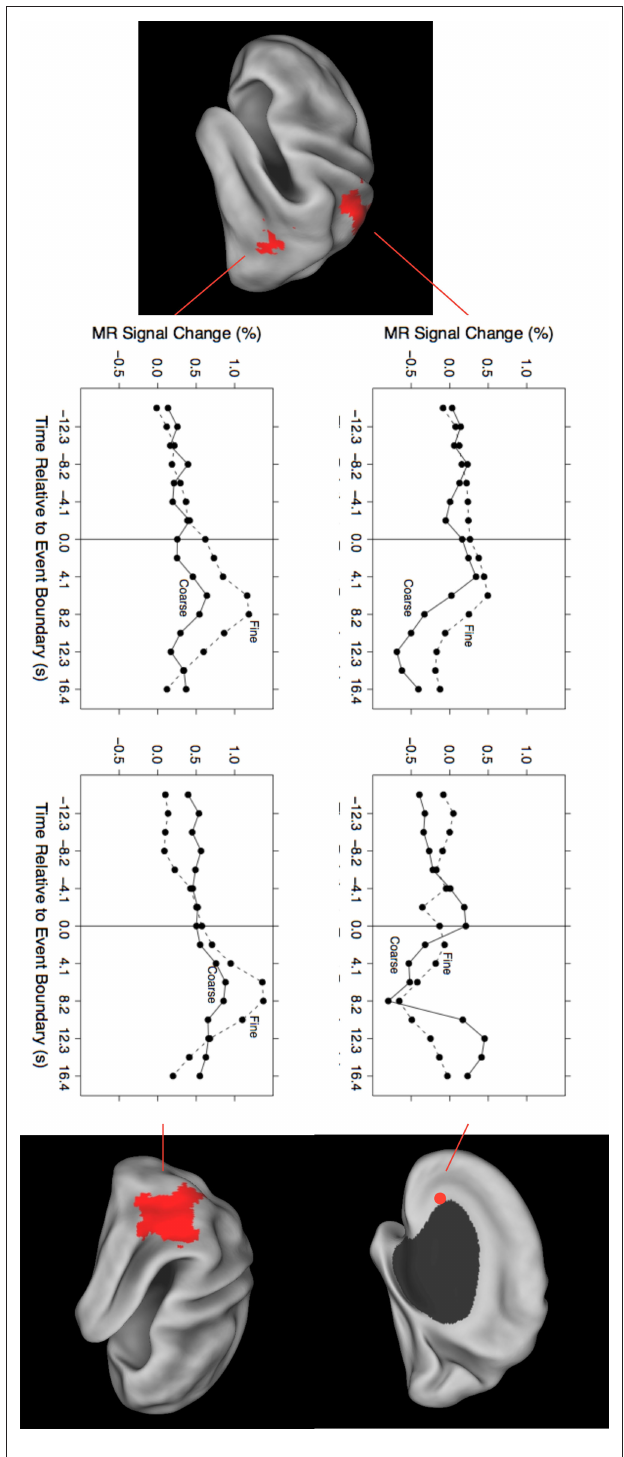
FIGuRE 2 | Timecourses for brain areas whose transient response to coarse and fine event boundaries differed significantly. Top left: left intraparietal sulcus (BA 2/7), − 24, − 48, 56; bottom left: left parietal-temporal- occipital junction (BA 39), − 51, − 63, 6; top right: right anterior cingulate gyrus (BA 24), 18, 26, 1; bottom right: right parietal-temporal-occipital junction (BA 39), 45, − 56,